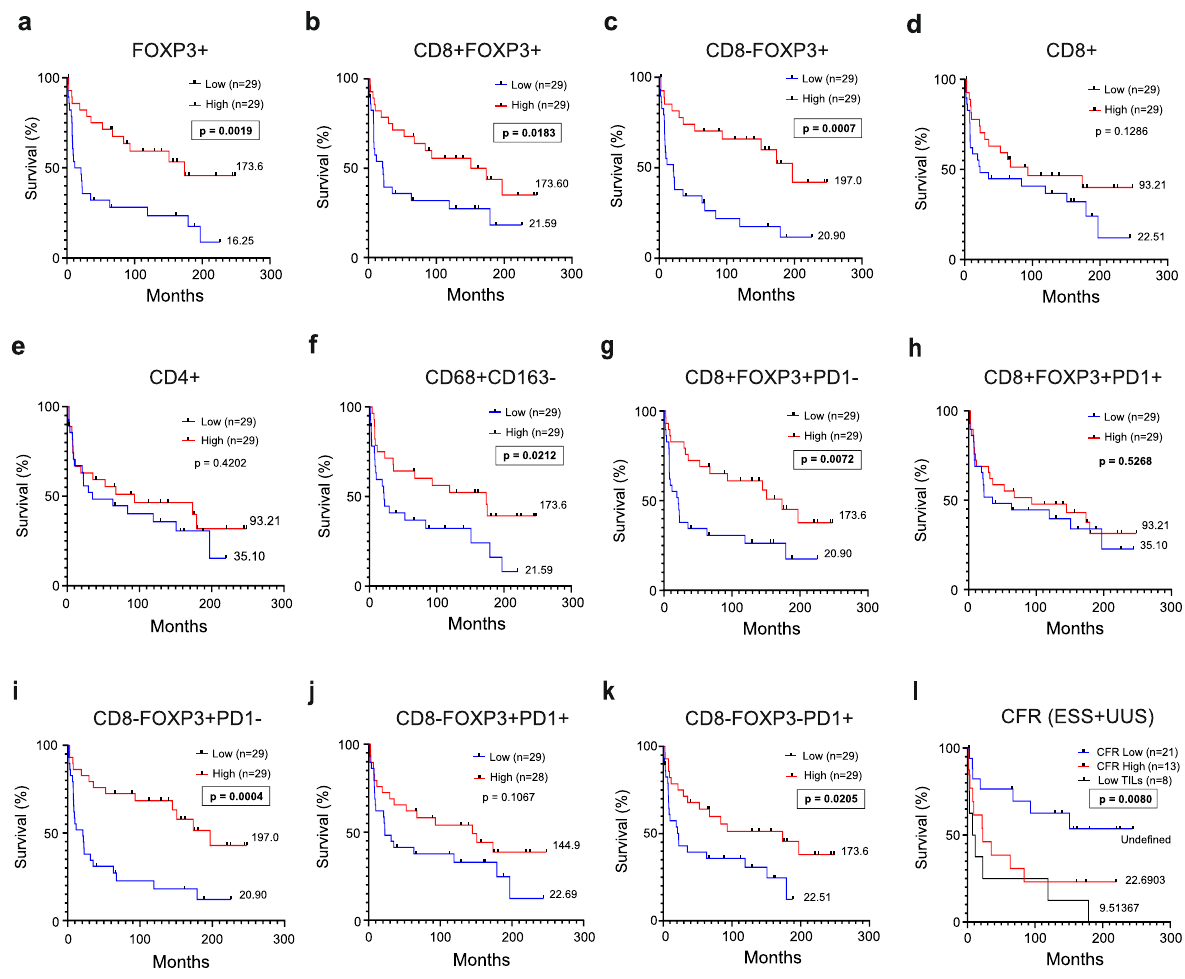
Fig. 4 FOXP3 + cell and M1-like macrophage density is associated with better survival. a – k Kaplan – Meier curves indicating patient overall survival. Patients were grouped based on median density of speci fi c cell subtypes regardless of diagnosis, excluding benign leiomyomas. Median survival is indicated for each patient group. a – e Kaplan – Meier curves of patients grouped based on distinct T cell markers indicate FOXP3 as a marker of good prognosis. f Kaplan – Meier curves based on M1-like type macrophage density show CD68 + CD163- cells to be a marker of improved survival. g – j Kaplan – Meier curves based on distinct FOXP3 + cell populations classi fi ed according to their PD-1 expression, show that only PD-1-negative FOXP3 + cell in fi ltration is associated with good prognosis. k Kaplan – Meier curves indicating overall survival based on density of CD8-FOXP3-PD-1 + cells. l Kaplan – Meier curves showing overall survival based on CD8 + FOXP3-/FOXP3 + ratio (CFR) including ESS and UUS cases (Low TILs group corresponds to CD8 + FOXP3- and FOXP3 + density below the 40th